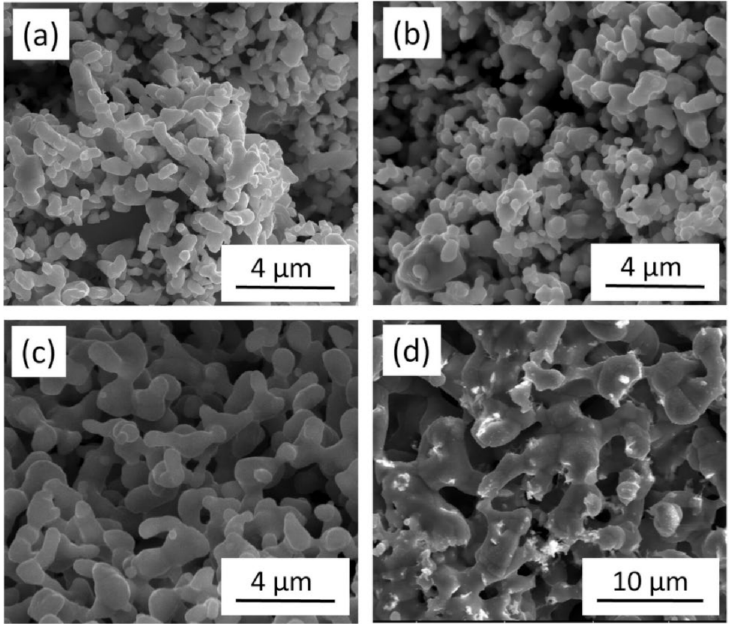
Figure 2. SEM images of ( a ) Cu foam materials processed by route C and subsequently annealed at ( b ) 300 ◦ C for 70 h, ( c ) 600 ◦ C for 5.5 h ( d ) and 800 ◦ C for 5